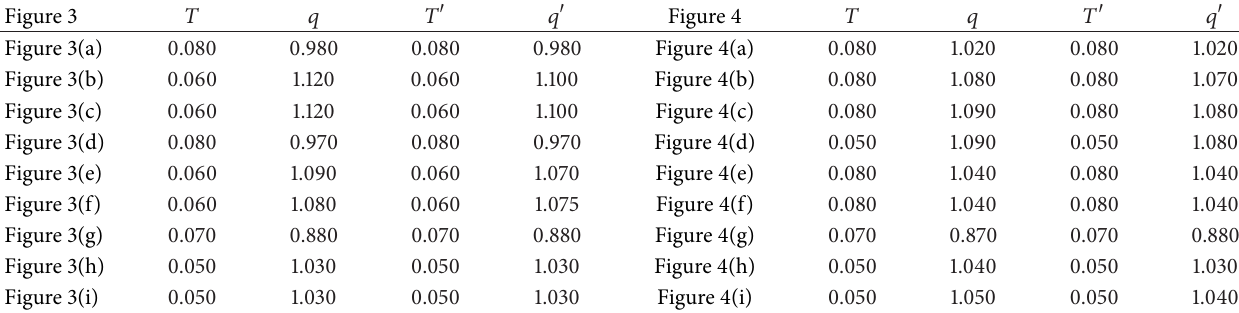
Table 2: Values of 𝑇 , 𝑞 , 𝑇 󸀠 , and 𝑞 󸀠 taken in Figures 3 and